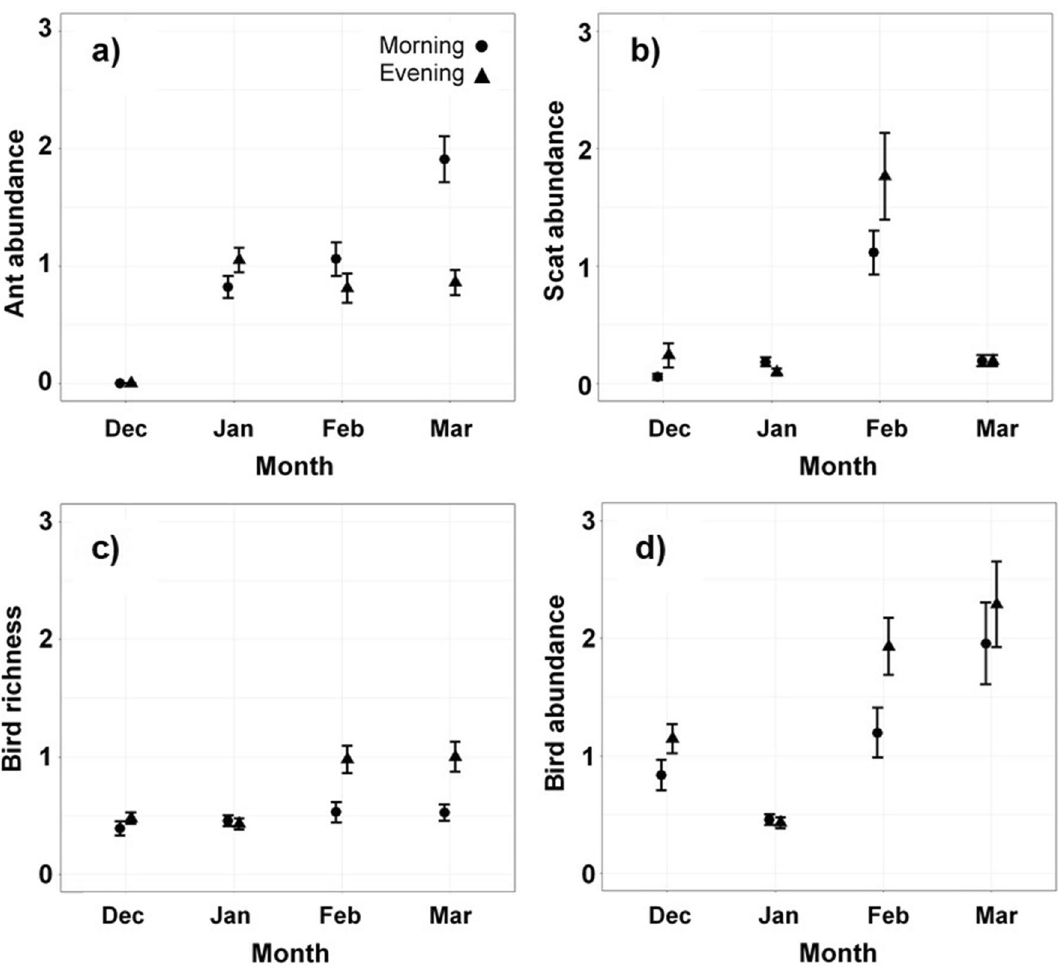
Figure 2. Mean ( a ) ant abundance, ( b ) scat abundance, ( c ) bird species richness and (d) bird abundance per morning and evening sampling session averaged by month with 95% confidence